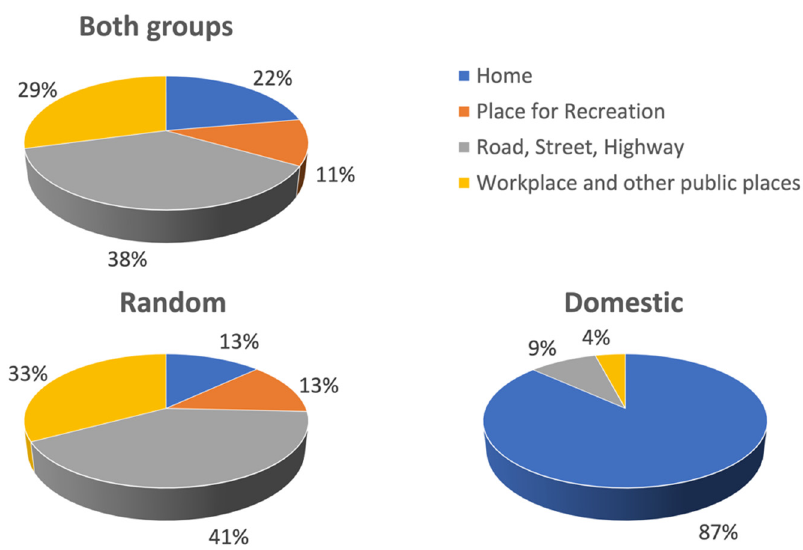
Figure 7. Where were victims of assault-related TBI in Melbourne, Australia, attacked between 30